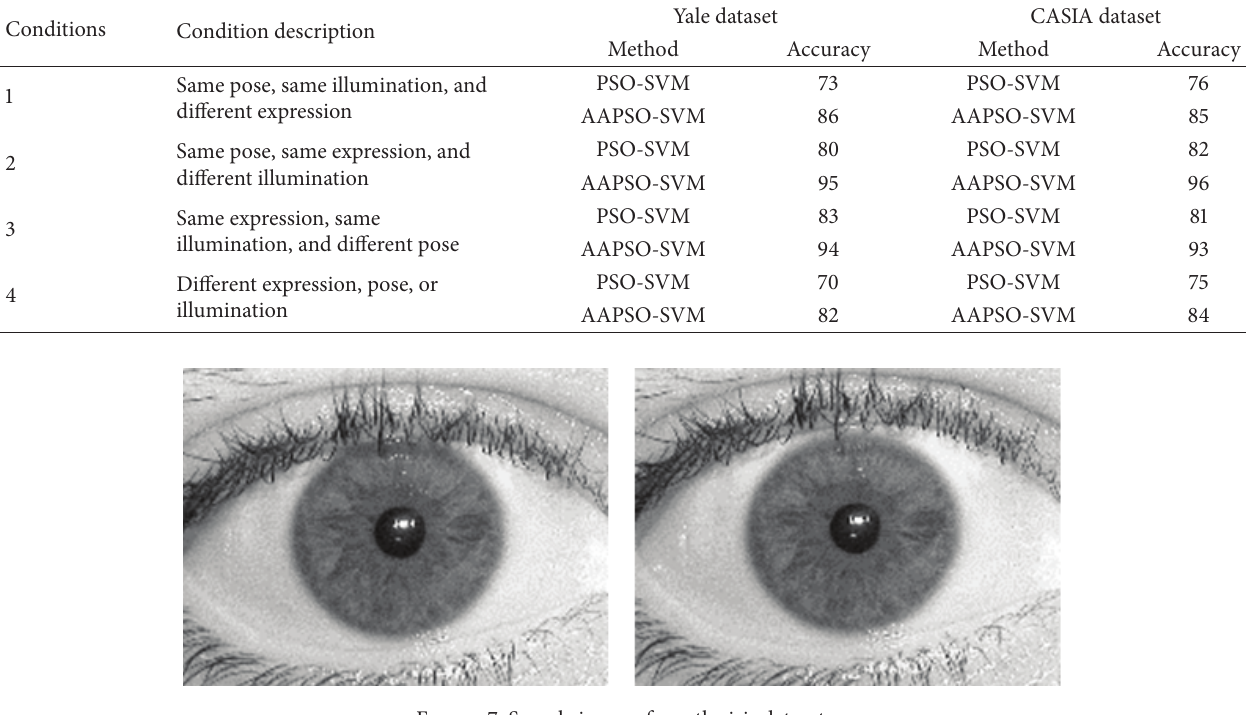
Figure 7: Sample images from the iris dataset.